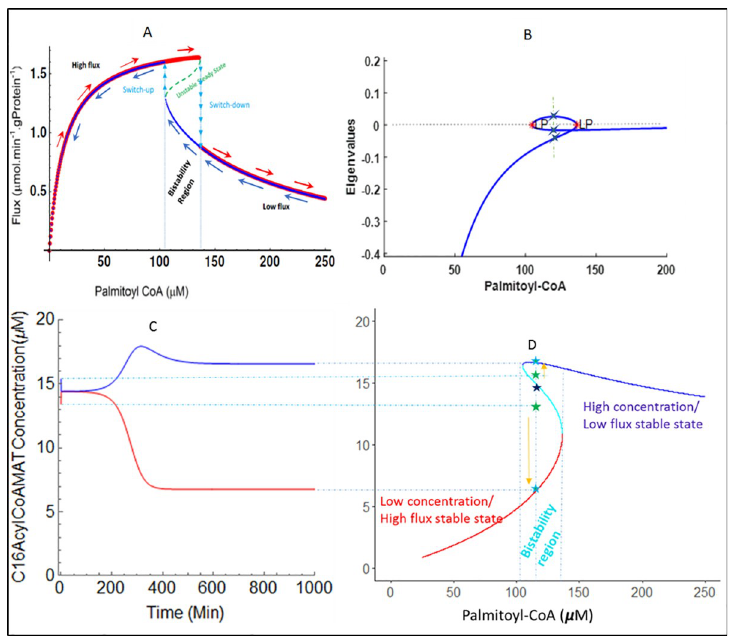
Fig 2. Bistability and hysteresis in mitochondrial fatty acid oxidation. The simulated steady state of mFAO uptake fluxes for increasing and decreasing palmitoyl-CoA concentrations are based on the rat liver model [20] with the [NAD+]: [NADH] ratio equal to 20 and all other parameters unchanged. A. Steady state uptake flux of palmitoyl-CoA for increasing (red curve) and decreasing (blue curve) palmitoyl-CoA concentrations. The arrows indicate in which direction the palmitoyl-CoA concentration was varied. B. The real parts of the eigenvalues of the Jacobian matrix plotted against the palmitoyl-CoA concentration. The bistable region between the critical points is characterized by two stable steady states, as can be inferred from their eigenvalues. C. Time course solution until convergence to a stable state starting from initial states close to the unstable stable. Cytosolic palmitoyl-CoA 120 μ M, initial mitochondrial palmitoyl-CoA 13.41 (red) or 15.41 μ M (blue). D. Steady-state mitochondrial against cytosolic palmitoyl-CoA; the light-blue line denotes the unstable state, and red and dark-blue lines, respectively the low- and high-flux